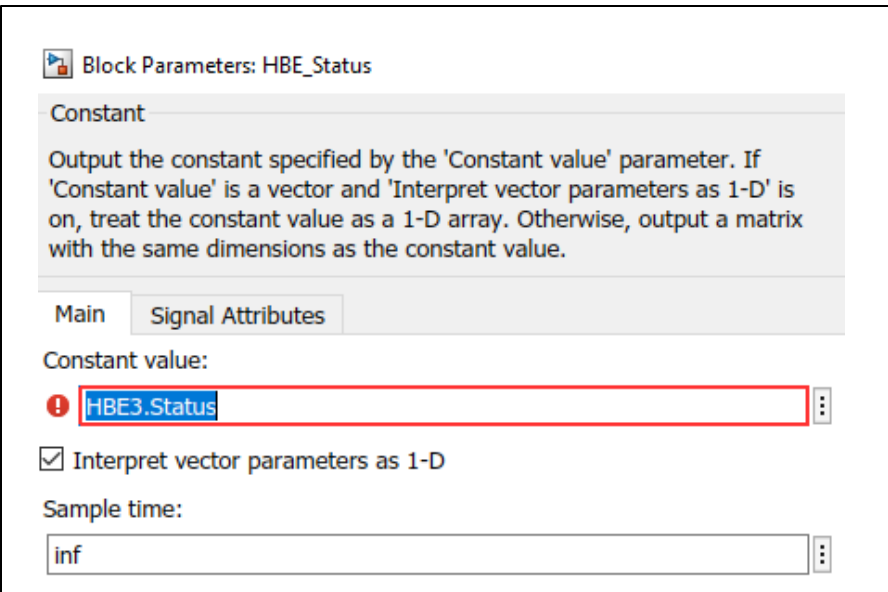
Figure A4. Customization of a Simulink block of type Constant. Table A3. Marking of the components of the GENERIC HYBRID BASIC EVENT Simulink block.